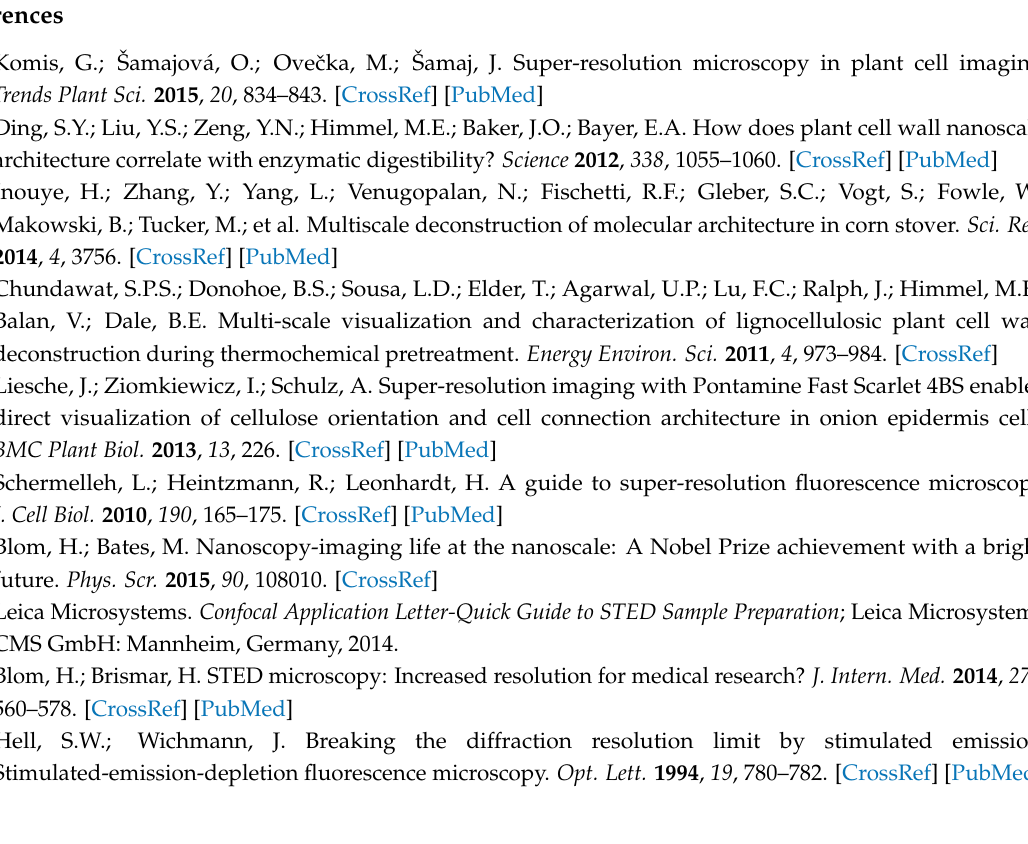
Figure S1: Autofluorescence contour map of PEG-R